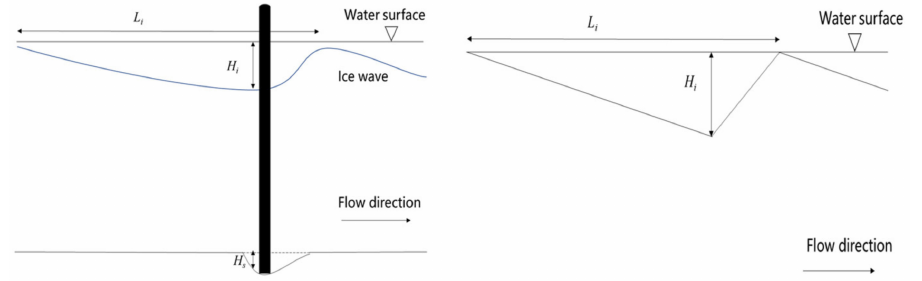
Figure 7. Simplified schematic diagram of an ice